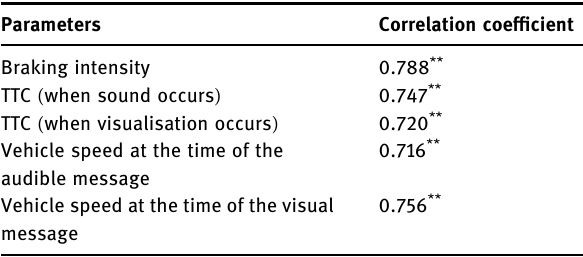
Vehicle speed at the time of the